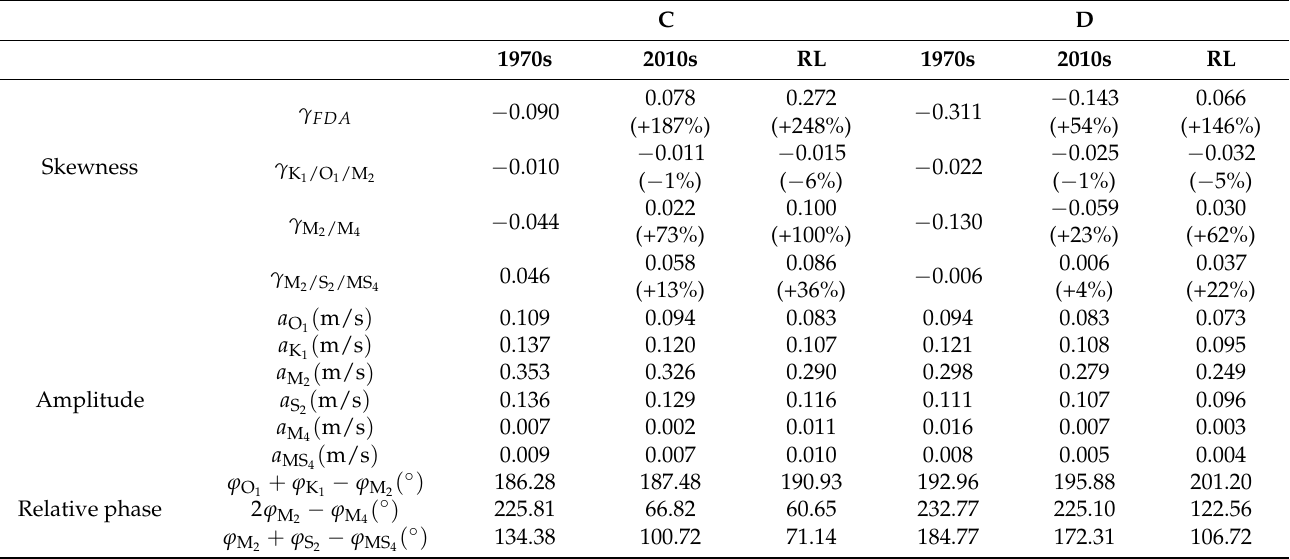
Figure 10. Variation of FDA with the shoreline change. The colors in the figure legend indicate the skewness values of FDA, and the solid lines are the contour lines of 0. Table 2. Comparison of tidal harmonic parameters in different scenarios at points C and